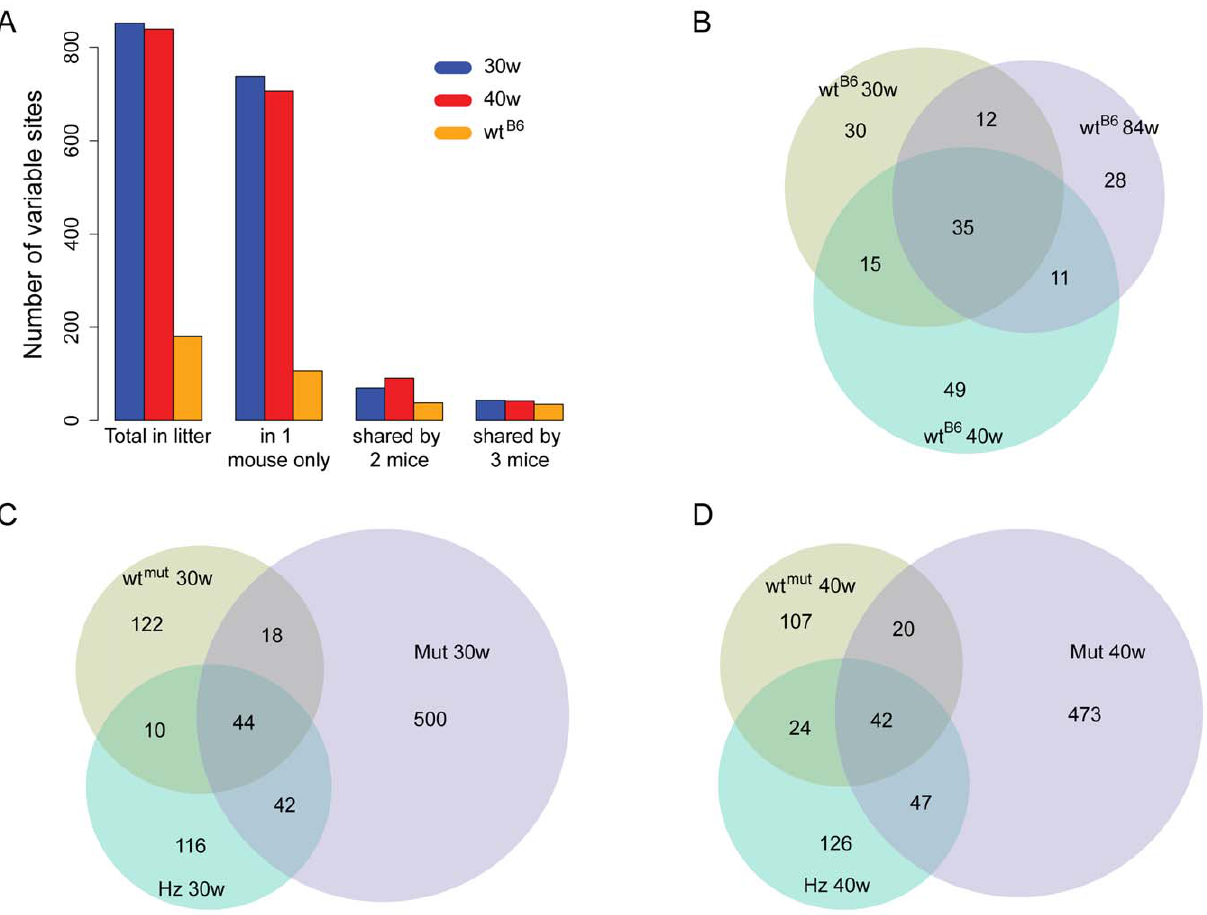
Figure 5. Number of shared high-frequency mtDNA mutation in the C57Bl/6N and mtDNA mutator sibling sets. A) Number of high frequency mutations (per site frequency . 0.5%) in the 30-week-old (30w; blue) and 40-week-old (40w; red) mutator siblings and C57Bl/6N mice (orange). The columns refer to the total number of such positions (‘‘Total in litter’’), positions found in only one of the three mice in each group (‘‘in 1 mouse only’’), in two of the three mice in each group (‘‘shared by 2 mice’’) and finally those shared between all three mice within each of the groups (‘‘shared by 3 mice’’). Venn Diagrams showing the distribution of high frequency mutations that are unique mutations and those shared between, B) C57Bl/6N samples, C) the 30-week-old mtDNA mutator sibling set and D) the 40-week-old mtDNA mutator sibling set. (Abbreviations: wt B6 = C57Bl/ 6N animal, wt mut = wildtype sibling of the mtDNA mutator mouse, Hz = heterozygous sibling of the mtDNA mutator mouse, Mut = mtDNA mutator mouse, 30w and 40w =30 weeks of age and 40 weeks of age,